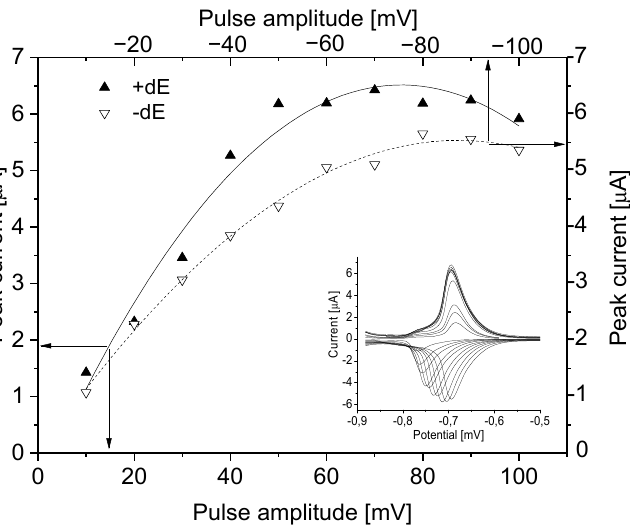
Figure 2. Pulse amplitude (from 10 mV to 100 mV) dependence on peak current in negative (---) and positive (—) mode. The electrode surface area 9.7 mm 2 . Instrumental parameters: Es = 4 mV, tp, tw = 10 ms, stirring rate 500 rpm.